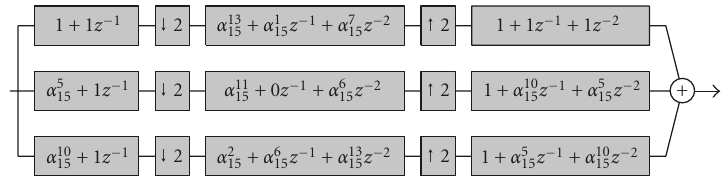
Figure 2: Filter bank representation of R [15,10], with M = 3, N = L = 2 (Example